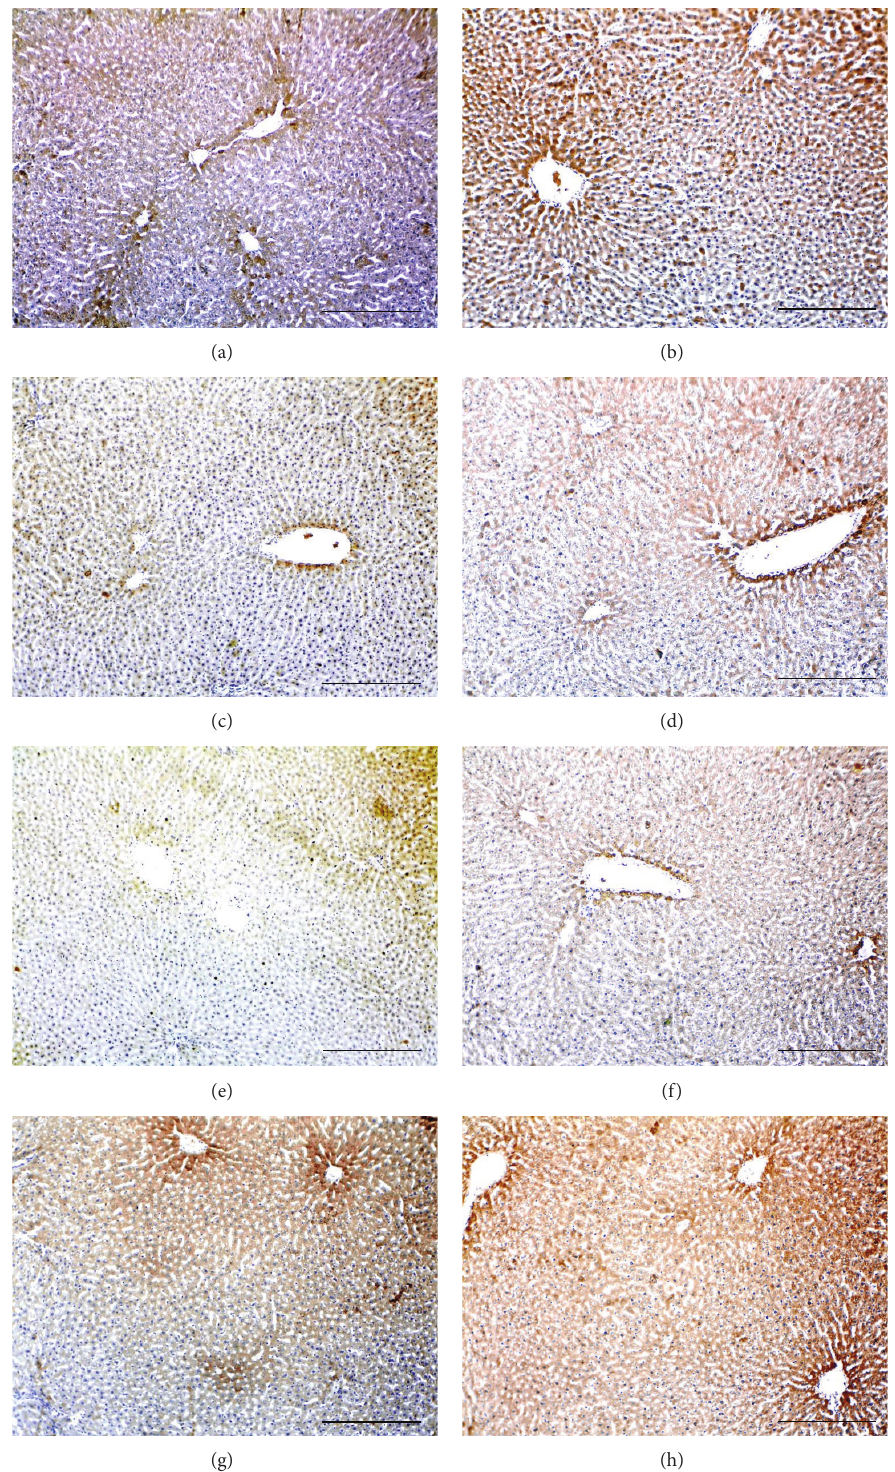
Figure 2: Immunohistochemistry localisation of activin type IIA (left column) and IIB (right column) receptors in control (a and b), Peg-only (c and d), Peg & RBV (e and f), and RBV-only (g and h) groups ( × 100 magnification, scale bar = 15 𝜇